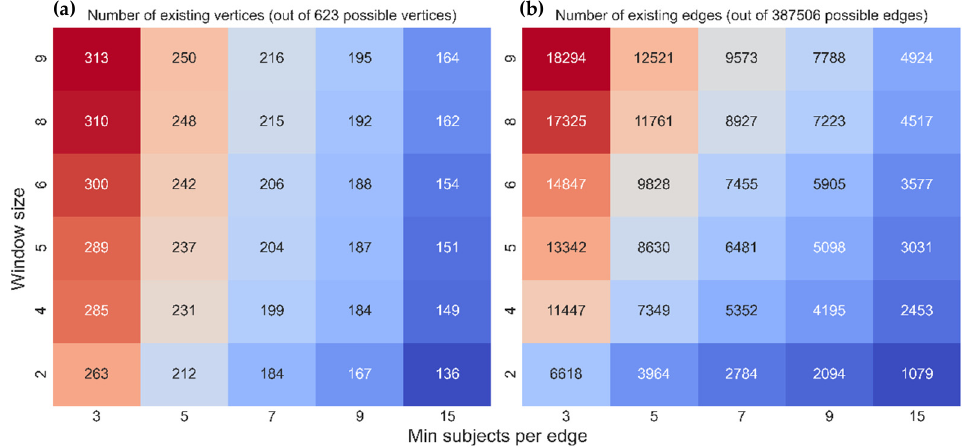
Figure A2. ( a ) Each cell in this heatmap represents the number of vertices that receive at least one weight given by the “distance function” for the pair of parameters MS (minimum subjects per edge) and WS (window size). ( b ) This heatmap is for the number of edges for the pair of parameters MS and WS. The x-axis denotes the range of MS values, and the y-axis denotes the range of WS values. The color highlights the number of vertices/edges. Bluer cells indicate a lower number of vertices/edges; redder cells indicate a higher number of vertices/edges .